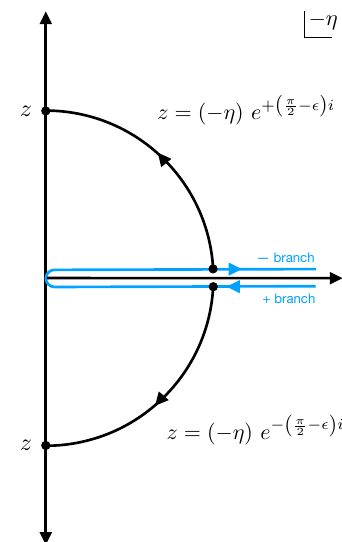
Figure 3. This figure displays the Wick rotations (2.13) from the perspective of the complex z plane (left) and the complex ( − η ) plane (right). Left: starting from the flat slicing (2.1) of EAdS, where z ∈ [0 , ∞ ) , by Wick rotating anti-clockwise one lands on the + branch of the in-in contour in the flat slicing (2.11) of dS and by Wick rotating clockwise one lands on the − branch of the in-in contour. Right: from the − (+) branch of the in-in contour one arrives to EAdS by rotating (anti-)clockwise. Similar figures were given in [37, 38], where further details can also be found.